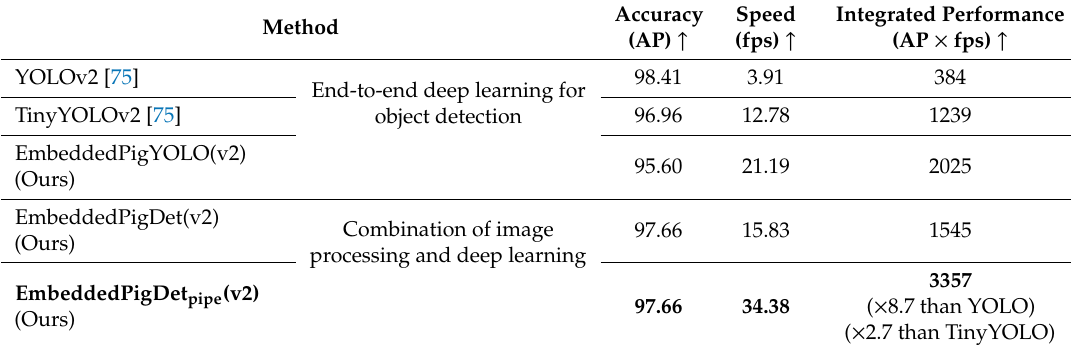
Table 6. Comparison of average performance on a Nano.